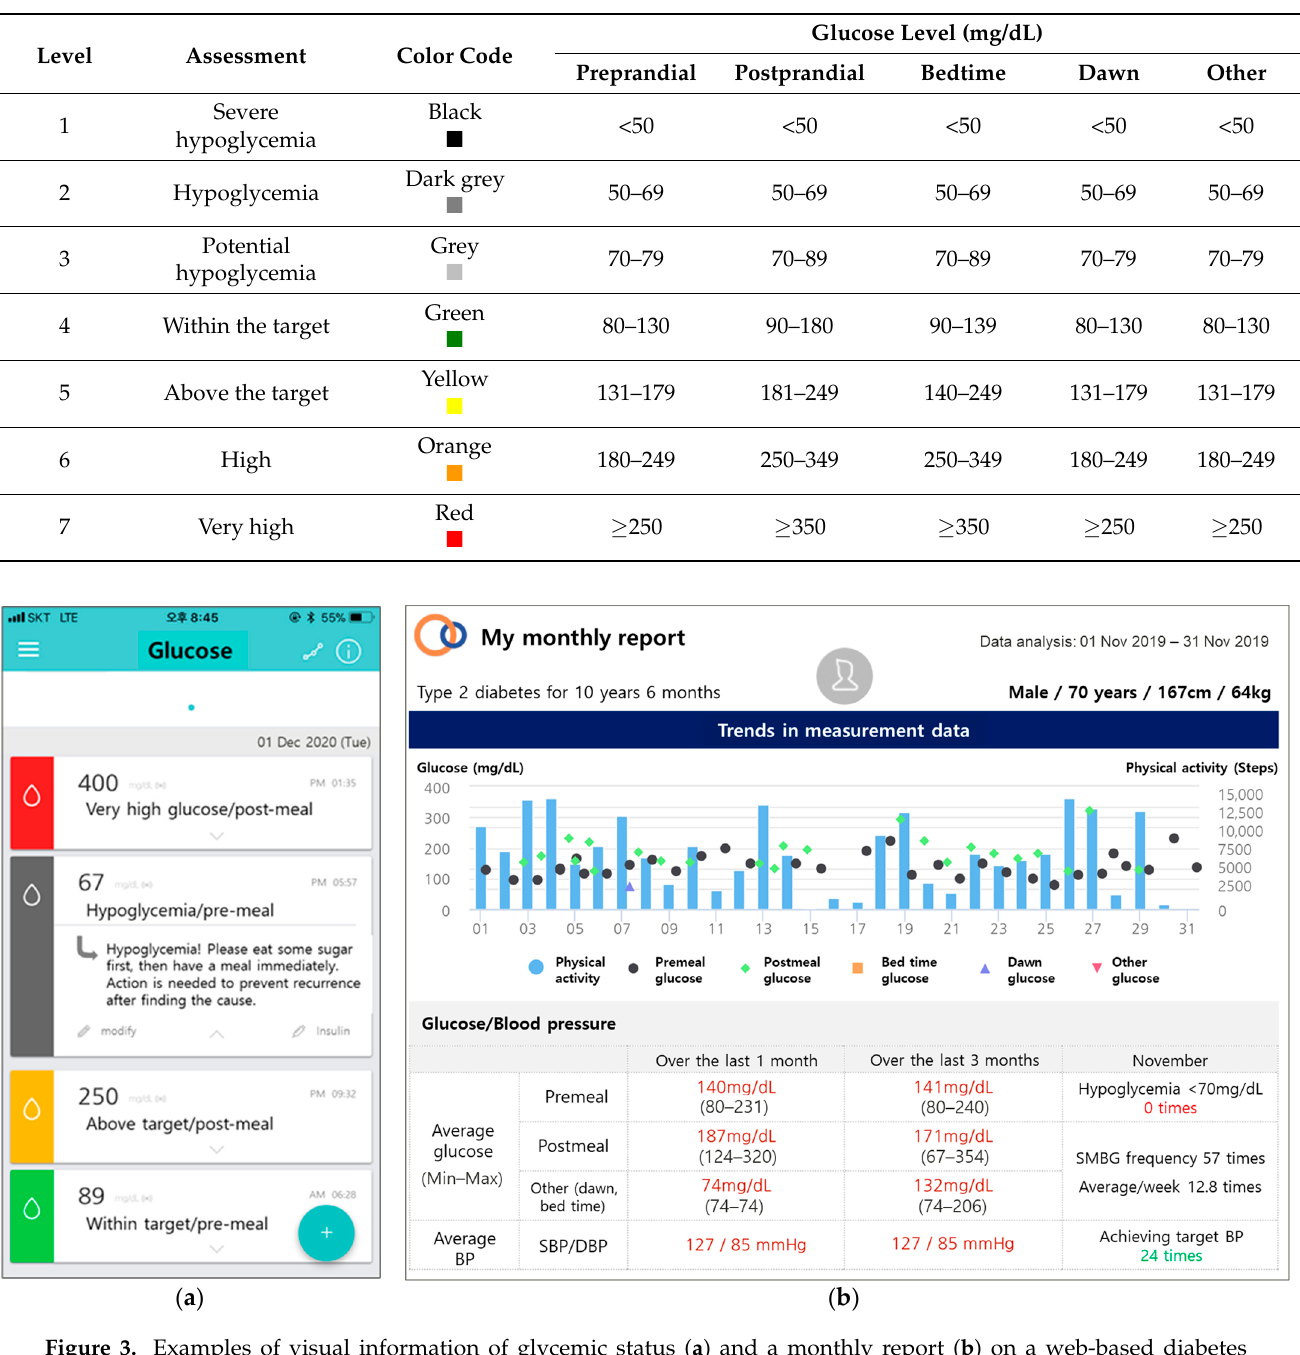
Table 2. Visual information of operational glycemic status on the mobile application in the intervention group.